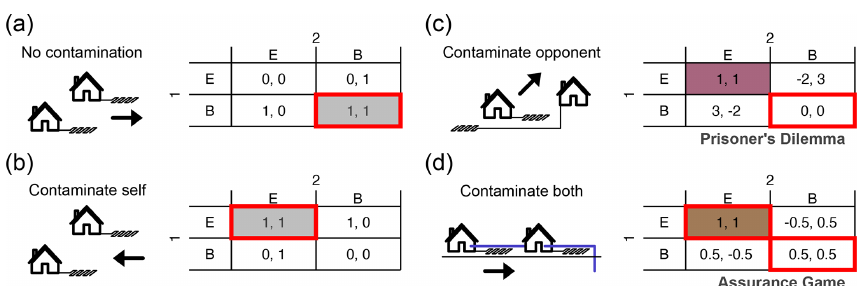
Figure 2. Payouts and social dilemmas in symmetric games. In each scenario, the choice to keep a basic septic system results in (a) no contamination, (b) self-contamination, (c) contamination of the other player, and (d) contamination of both players. Payouts represent the situation where C x = 1 . 5 C σ . The utility is normalized so that the social optimal scenario produces an average payout of 1, and the joint worst scenario produces an average payout of 0. Arrows indicate direction of the groundwater flow. For the scenarios in panels (a) and (b) , the Nash equilibrium (red outline) and social optimum (gray shading) are equivalent. A social dilemma arises for the scenarios in panels (c) and (d) , as there exists a difference between (at least one) Nash equilibrium and the social optimum (red for the prisoner’s dilemma and orange for the stag